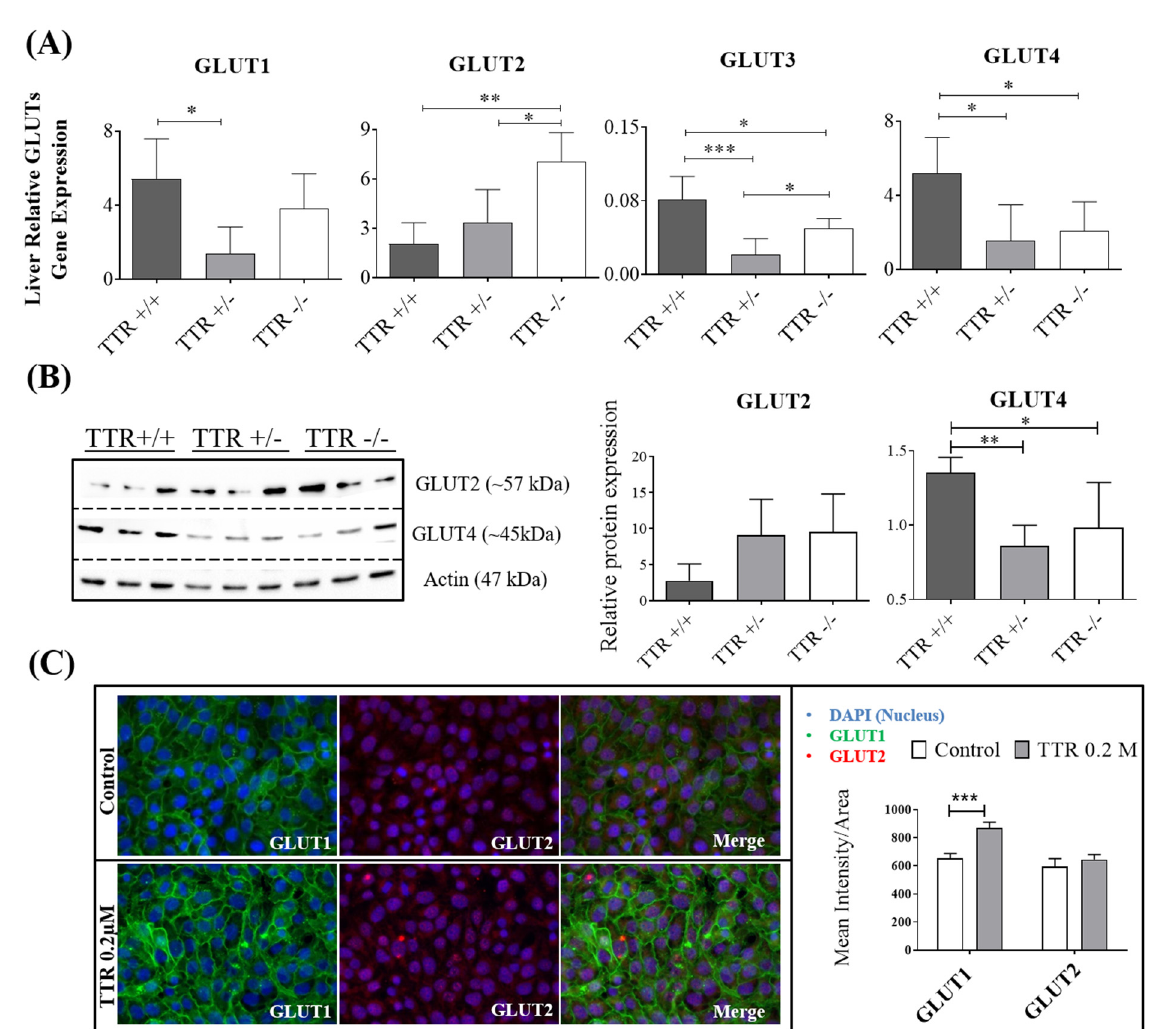
Figure 2. Effect of TTR on hepatic glucose transporters, assessed by qRT-PCR, Western blot, and immunocytochemistry. ( A ) In mice, at mRNA level, haploinsufficiency of TTR in TTR+/ − mice livers significantly decreased expression of GLUT1, GLUT3, and GLUT4, compared to TTR+/+ livers, while TTR deficiency in TTR − / − mice livers showed lower expression of GLUT3 and GLUT4 and higher expression of GLUT2, compared to TTR+/+ livers ( N = 4 for each genotype). ( B ) In primary hepatocytes, and at protein levels, cells derived from TTR+/ − and TTR − / − mice showed lower expression of GLUT4 ( N = 3 for each genotype). ( C ) HepG2 cells also showed higher protein levels of GLUT1 when incubated with h rTTR (0.2 µ M), compared to untreated cells ( N = 4 for each condition). Data are expressed as mean ± SD. Significant results are indicated by * when p < 0.05, ** when p < 0.01, and *** when p <